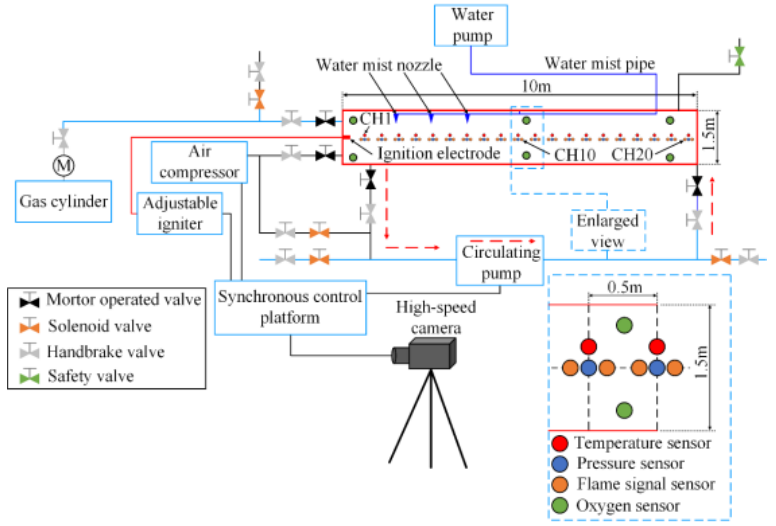
Figure 4. Scheme of the test site to establish the conditions necessary to contain an explosion during a fire under water mist extinguishing [48].